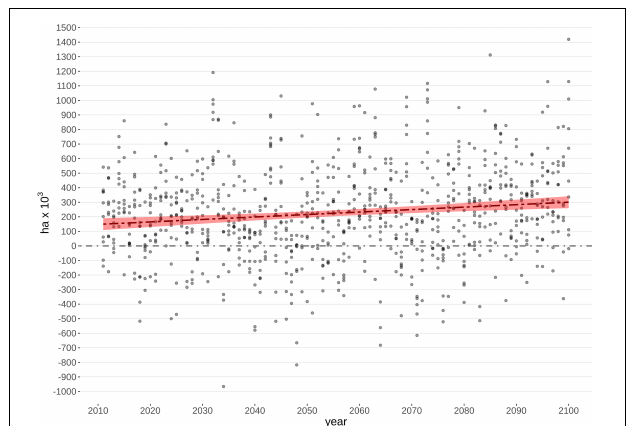
FIGURE 5 | Difference in mean area burned from 2011 to 2100 when simulating landscape change and wildfire between with climate-sensitive and non-climate-sensitive models [Scenarios (II, V, VI, VIII) – (I, III, IV, VII)] for the Taiga Plains Ecozone within the Northwest Territories (dots). The red line represents the fitted linear regression of values through time ( y = 1.7x – 3258.2; p =